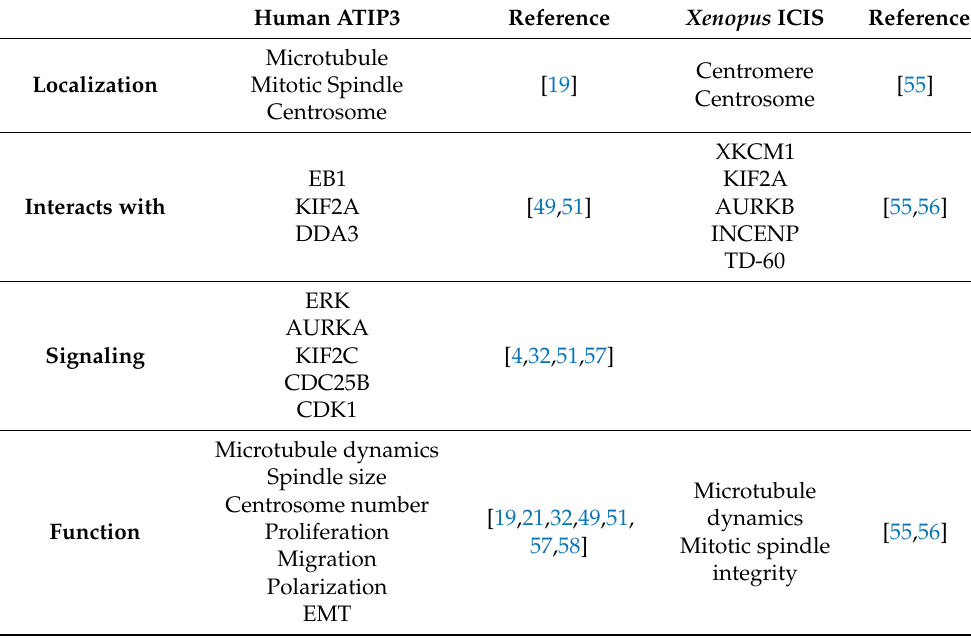
Table 2. ATIP3 localization and function in human and Xenopus